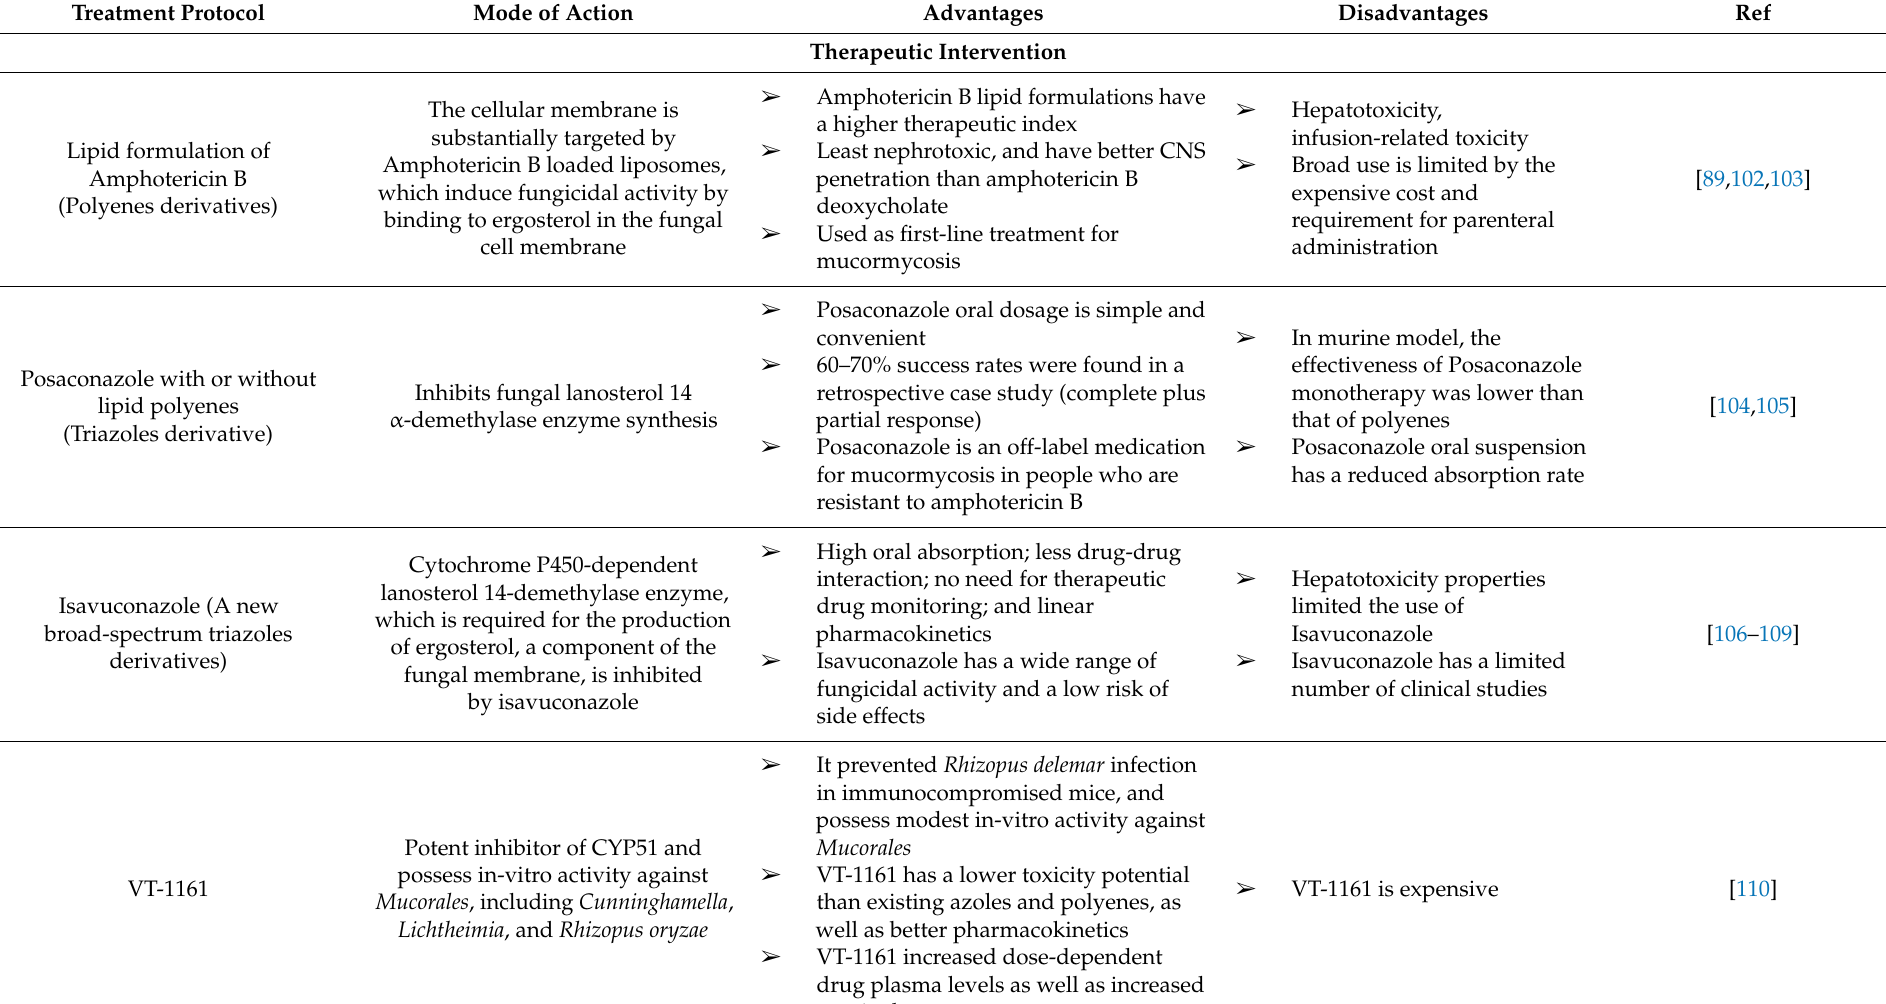
Table 1. Demonstrated mode of action, advantages and disadvantages of various medications, as well as surgical management for mucormycosis infection healing. Treatment